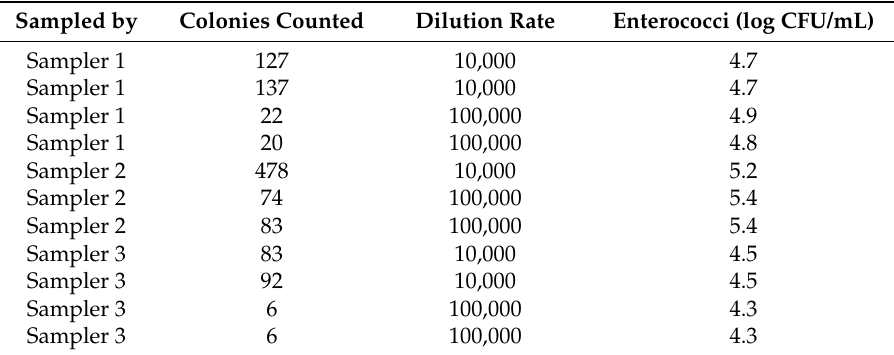
Table A4. Raw data from the differences in sampling experiments.